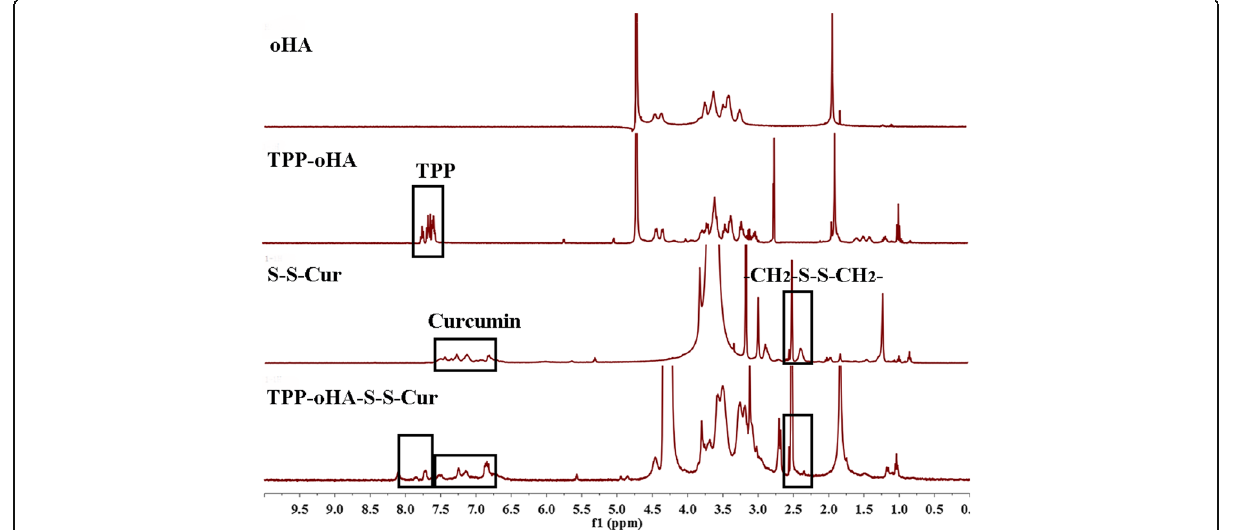
Fig. 3 1 HNMR spectra of oHA, TPP-oHA, S-S-Cur, and